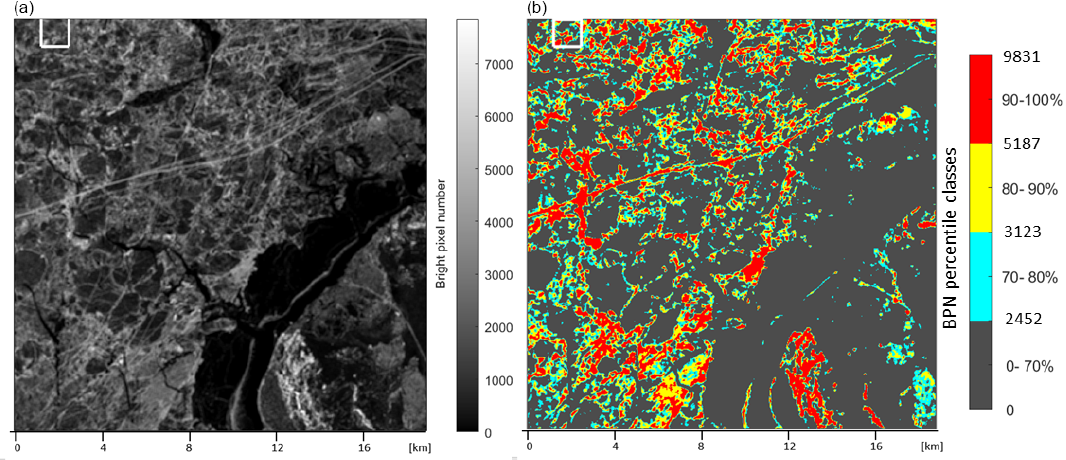
Figure 6. The 15200 × 15200 contextual image (a) and corresponding category image (b) derived from the full image with BPP 20% and sliding-block side length 101. The colour bar extends to the maximum observed BPN in the blocks, 9831. The location of the 1024 × 1024 subimage is also indicated.